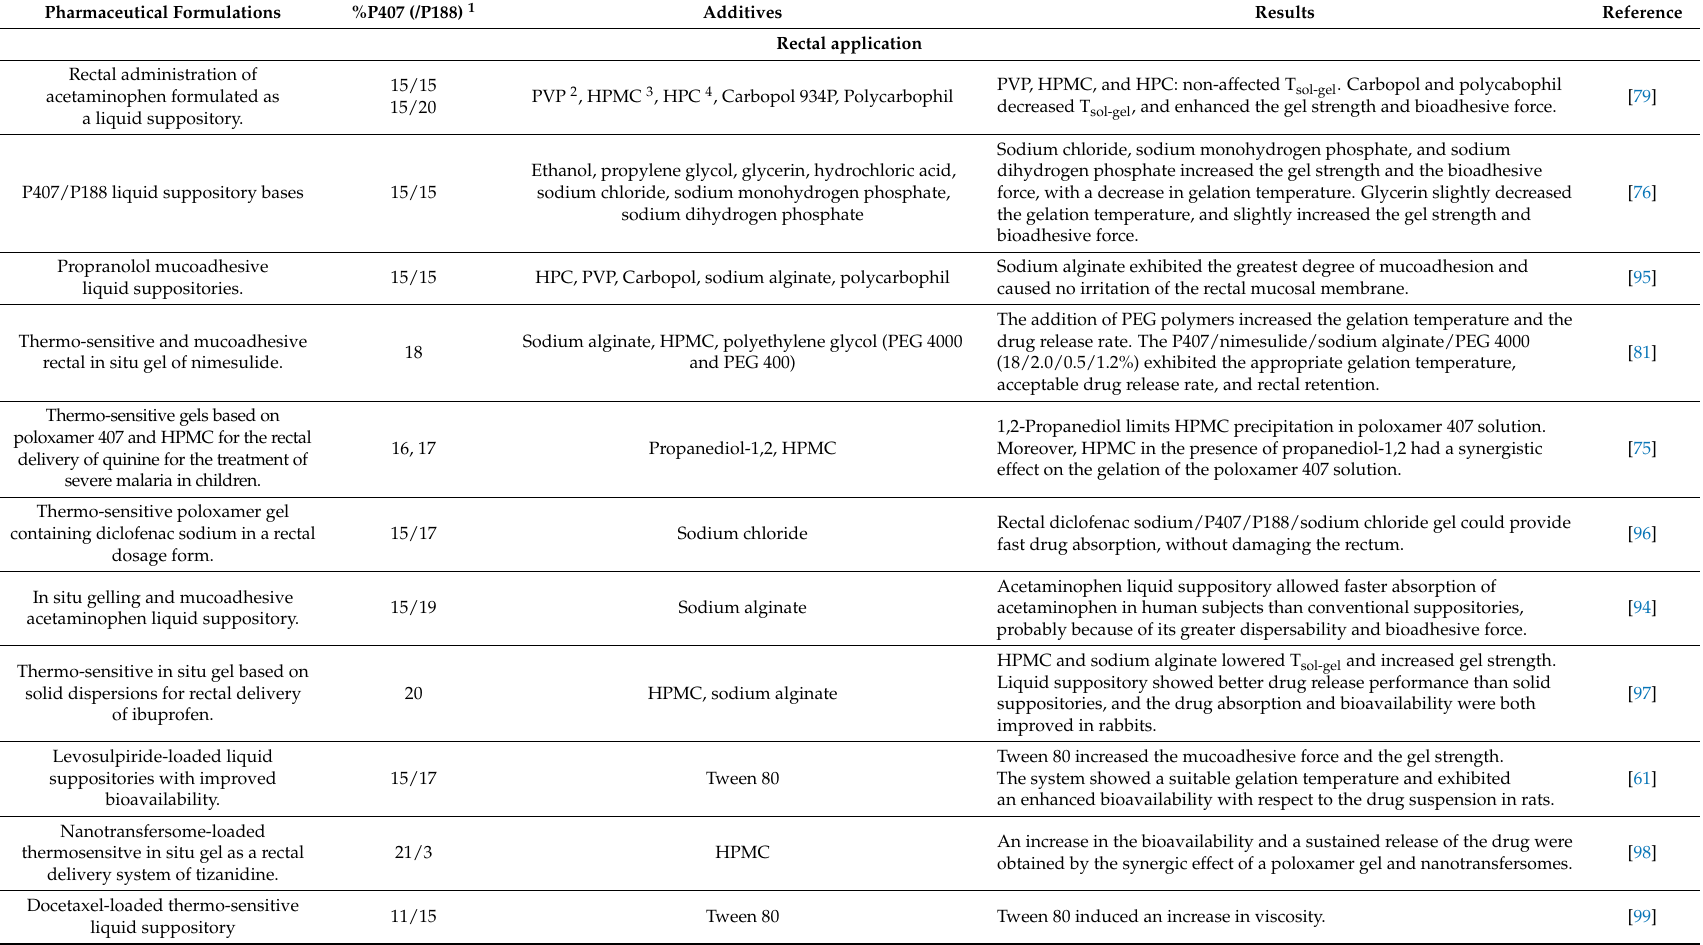
Table 1. Examples of P407-based mucoadhesive hydrogels and their potential